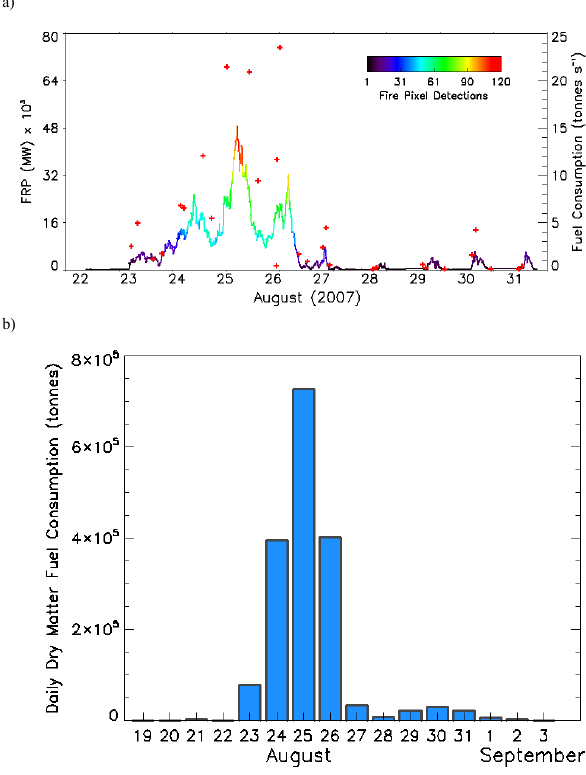
Figure 9. (a) Time series of atmospherically corrected SEVIRI FRP measures (MW, left axis) and equivalent fuel consumption rate (ts − 1 ) for the Peloponnese wildfires, as measured between 22 and 31 August 2007 using the LSA SAF SEVIRI FRP-PIXEL prod- uct. Also shown are the atmospherically corrected MODIS FRP data collected over the same time period (red crosses). Note that for clarity of presentation the MODIS FRP measure recorded on 25 August (12:05UTC) is not shown as this exceeds 180GW, and SEVIRI reaches a far lower value due to strong prevalence of SE- VIRI MWIR channel pixel saturation at this time. (b) Daily total dry matter fuel consumption estimated using the time-integrated SE- VIRI FRP data. We estimate 1.74Tg of fuel was consumed in these fires, the bulk of which was burned between 24 and 26